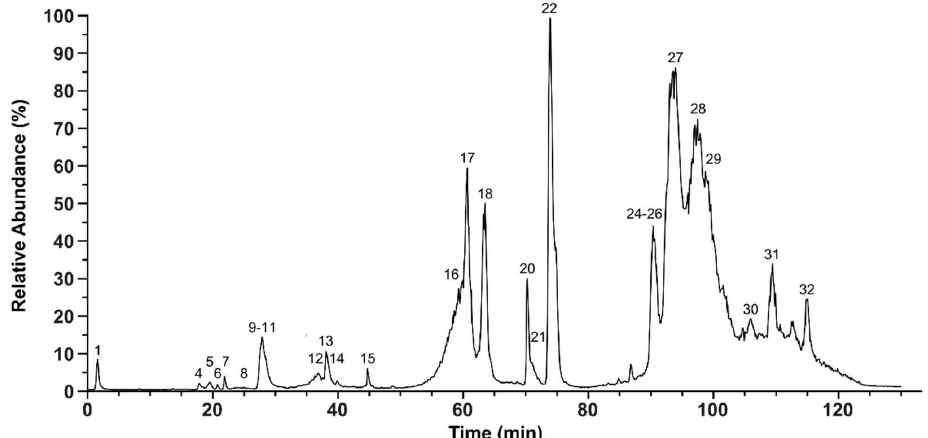
Figure 1. Total ion chromatogram of the P. flavoviridis venom for IMP and TD. The total ion counts in P. flavoviridis crude venom were measured by the HPLC-ESI-MS of native crude venom. The relative abundance was set to 100% for the highest peak. The peak nomenclature is based on the chromatogram fractions (shown in Figure 2). The identified molecular masses of intact peptides and proteins are listed Table S1.